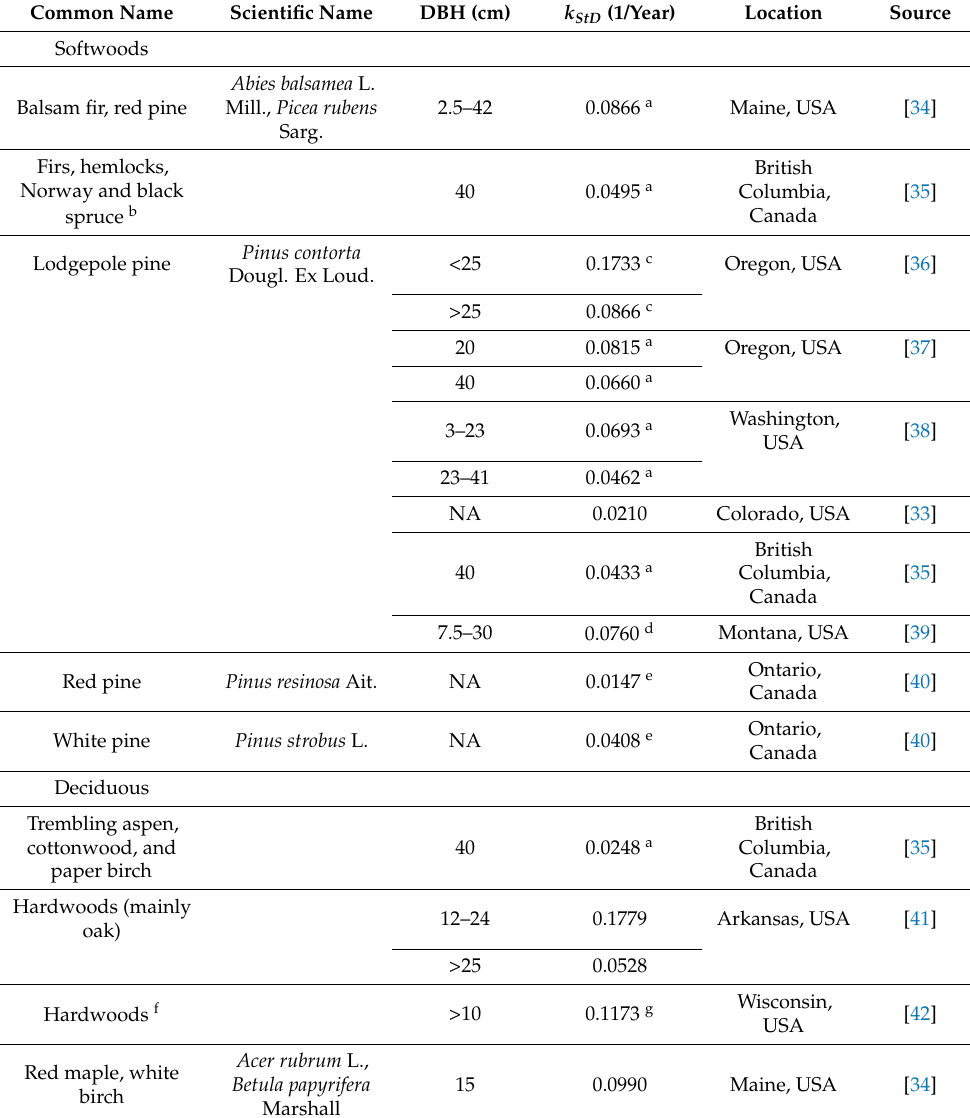
Table 1. Estimated decay rates of standing dead trees ( k StD ) in North American boreal